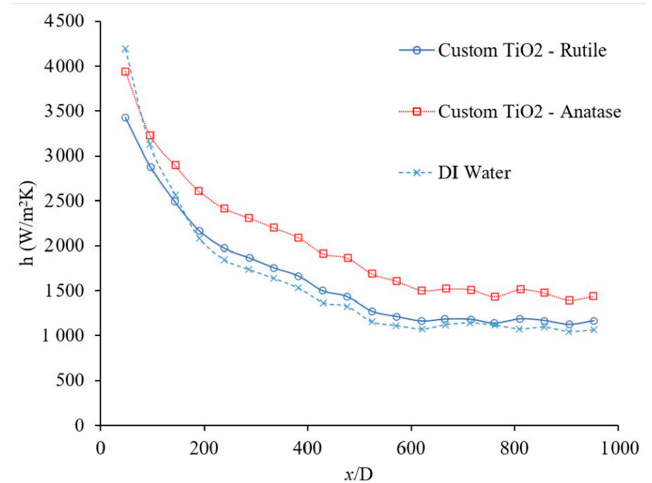
Figure 16. Variation of forced convection heat transfer coefficient as a function of distance for water-based nanofluids using 1 wt % nanofluid and the range of Reynolds number inside the microchannel was 150–200. Comparison is between two variations of semiconductors TiO 2 nanoparticles made in our research group [40].